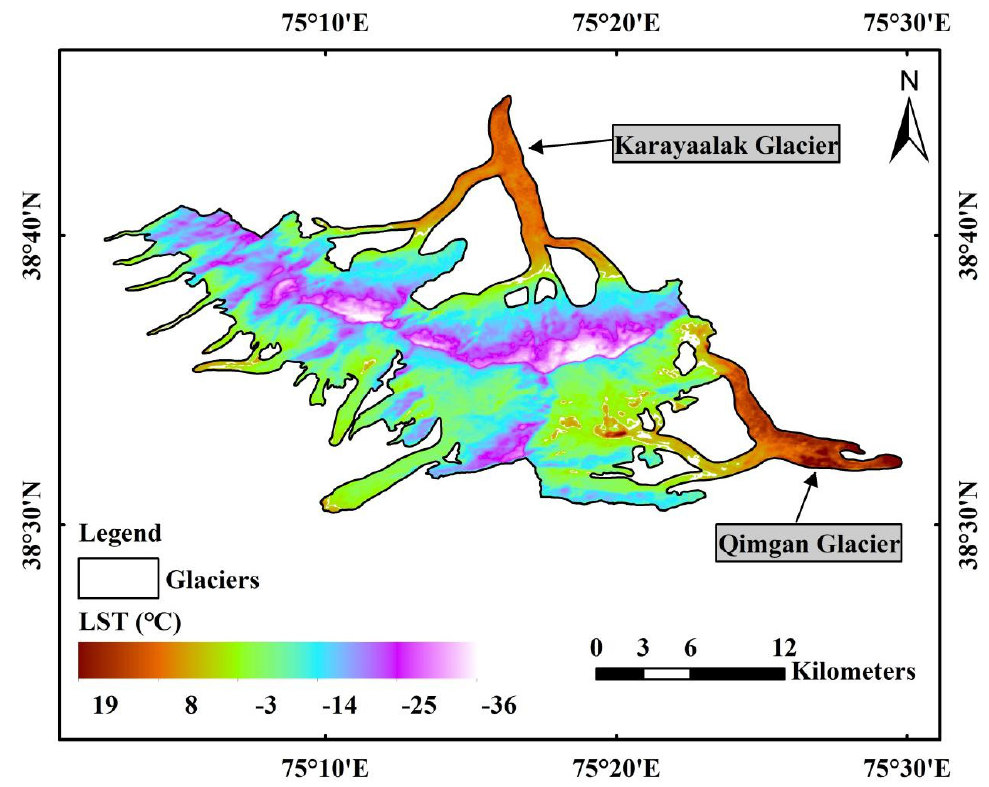
Figure 6. Land Surface Temperature (LST) of di ff erent land cover types at the Kongur Tagh glacier of the eastern Pamir.